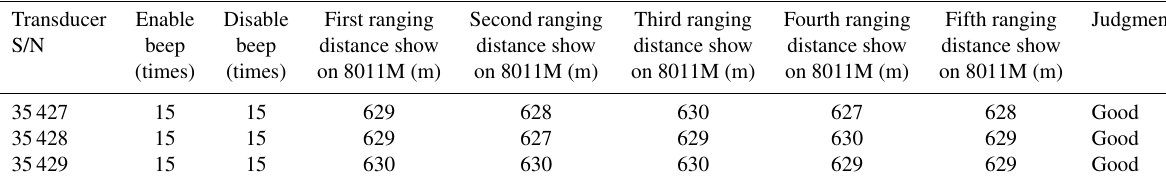
Table 4. Example results for the functional test of the acoustic transducer.